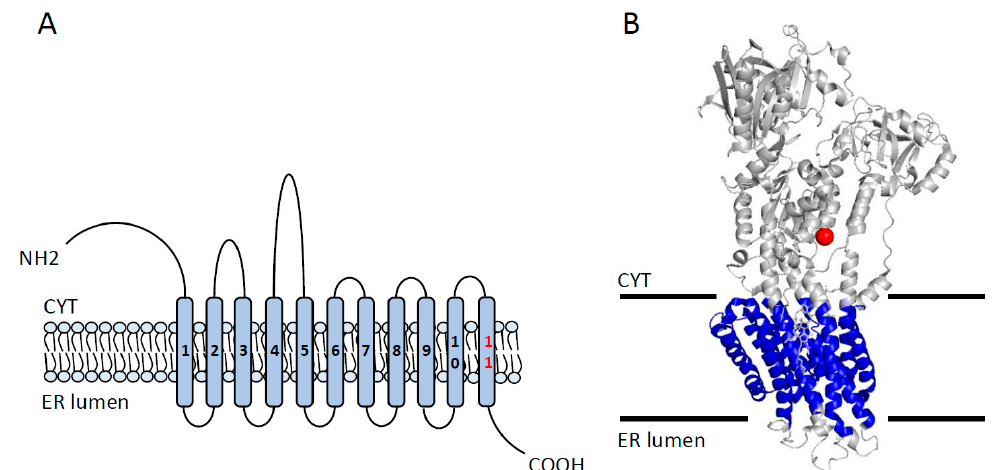
Figure 3. The overall structure of SERCA (Sarco/endoplasmic reticulum Ca 2+ ATPase) pump. ( A ) The topology of SERCA showing 10 transmembrane segments (TMS (transmembrane segment) 11 is found only in SERCA2b), with a large cytoplasmic N-terminal, large cytoplasmic loops, and a luminal C-terminal. ( B ) Overall 3D-architecture of SERCA transporter in the E2-state complexed with a Thapsigargin derivative Boc-(phi)Tg (Protein Data Bank [PDB] code 3NAN). Cytoplasmic and luminal loops are shown in gray, TMSs are shown in blue, and Tg inhibitor is shown in red. CYT = cytoplasm; ER lumen = endoplasmic reticulum lumen.